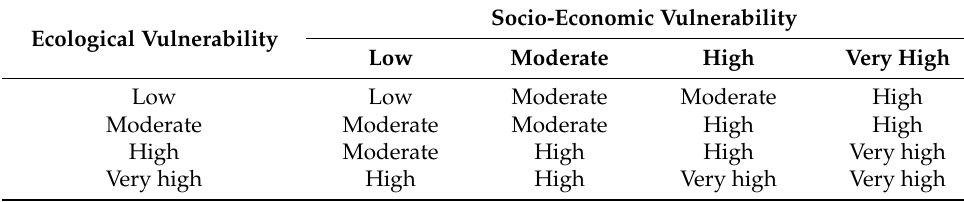
Table 10. Combination of ecological and socio-economic vulnerability assessment to obtain the integrated vulnerability to landslide.